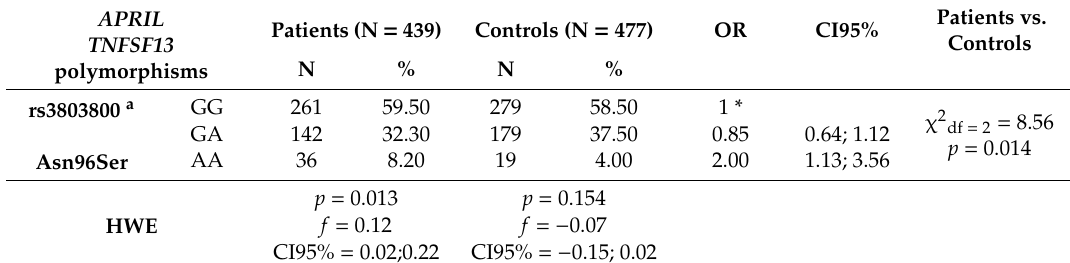
Table 1. Genotype distribution of APRIL ( TNFSF13) rs3803800 polymorphism and TACI (